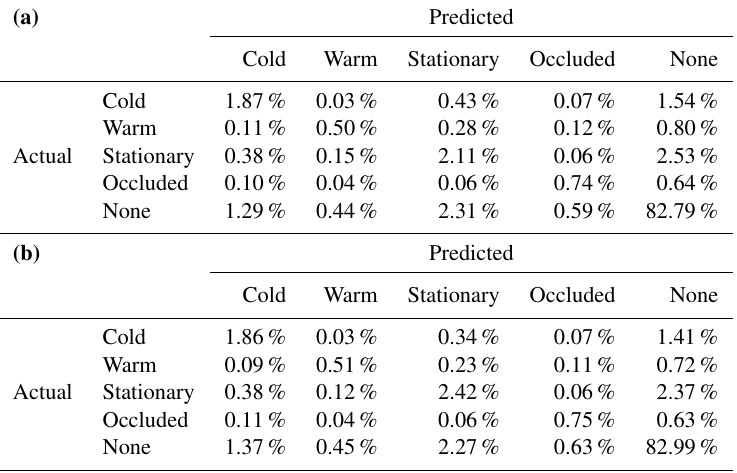
Table 3. (a) The confusion matrix as percentages of total grid cells for all front categories over the 2008–2015 validation time range. (b) The confusion matrix as percentages of total grid cells for all front categories over the 2003–2007 training time range.